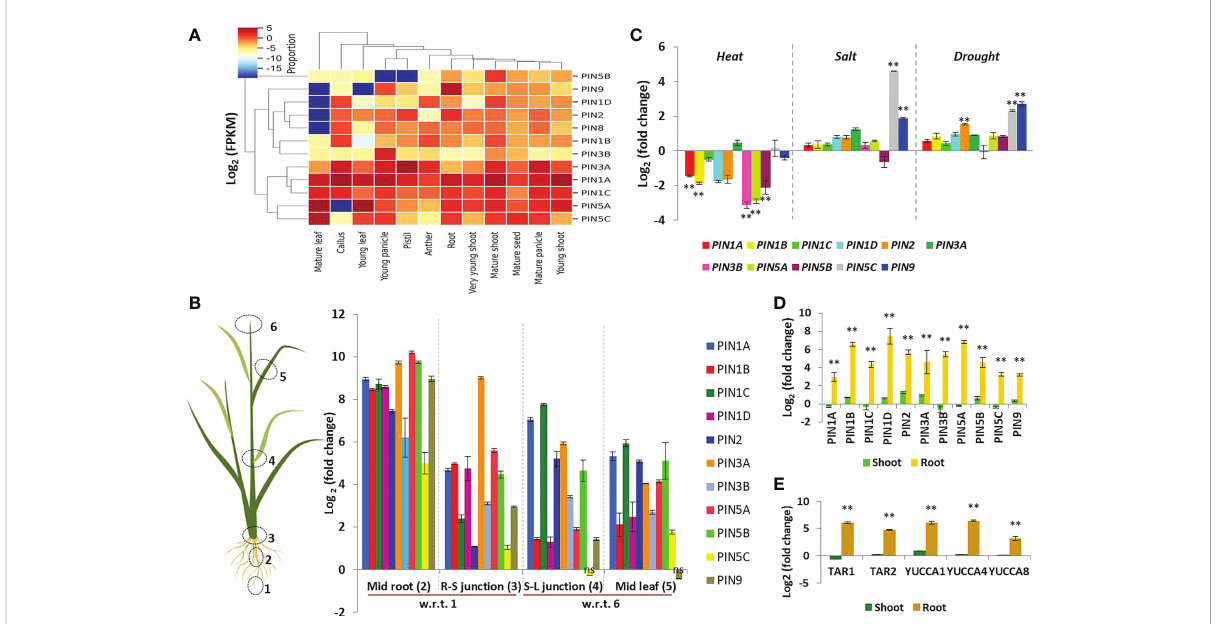
FIGURE 6 Expression patterns of rice PIN genes in different tissues under different conditions. (A) Expression pro fi ling of PIN genes of rice at different developmental stages using RNA sequencing data available at the Rice Expression Database. The color bar in the right-hand side of the heat map represents relative expression values. (B) Expression pro fi ling of rice PIN genes in growing (i.e., mid root, 2; mid leaf, 5) and differentiating (i.e., root-shoot or R-S junction, 3; stem-leaf or S-L junction, 4) regions of rice seedlings in comparison to the root tip, 1 region, and leaf tip, 6 region, by qRT-PCR (n = 3, non-signi fi cant changes are marked as “ ns ” ). (C) Changes in the expression levels of PIN genes in response to heat, salt, and drought stress (n = 3). (D) Upregulation of PIN genes in the roots of rice seedlings when subjected to IAA treatment for 3 h (n = 3). (E) Induction in the expression of IAA biosynthesis genes in the roots of rice seedlings post 3 h of IAA treatment (n = 3). Asterisks (**) indicate differences statistically signi fi cant at 0.01